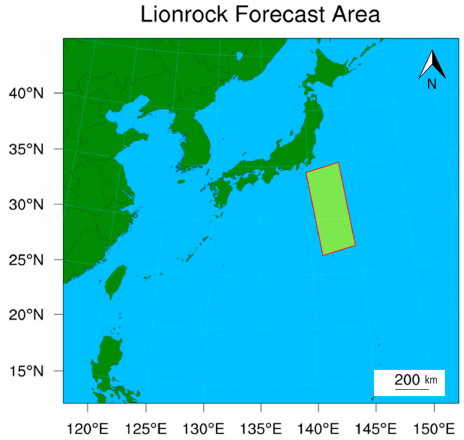
Figure 4. The domain area for theWeather Research and Forecasting (WRF) model simulation. The corverage of SAR observations is shownin the red frame.